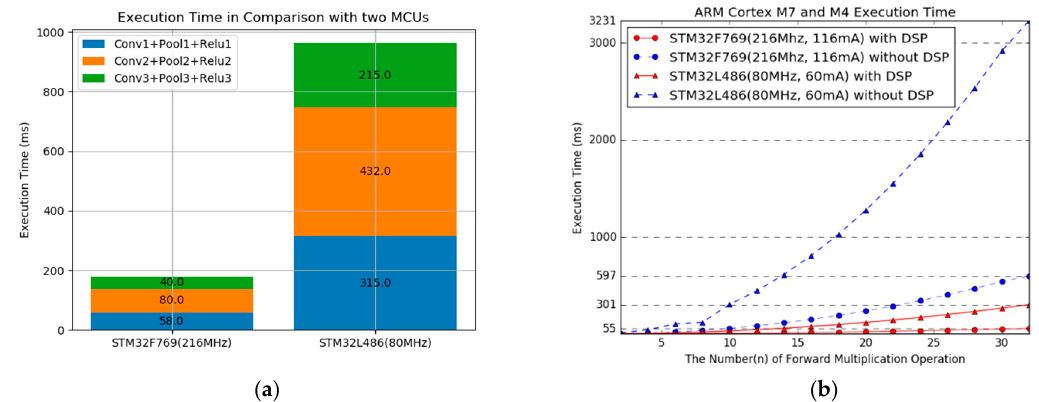
Figure 5. Execution time comparison with two boards used in experiment. ( a ) Execution time of the three convolutional layers of applied deep learning model. ( b ) Execution time by increases in the kernel depth of convolutional layer 1 according to the DSP unit.